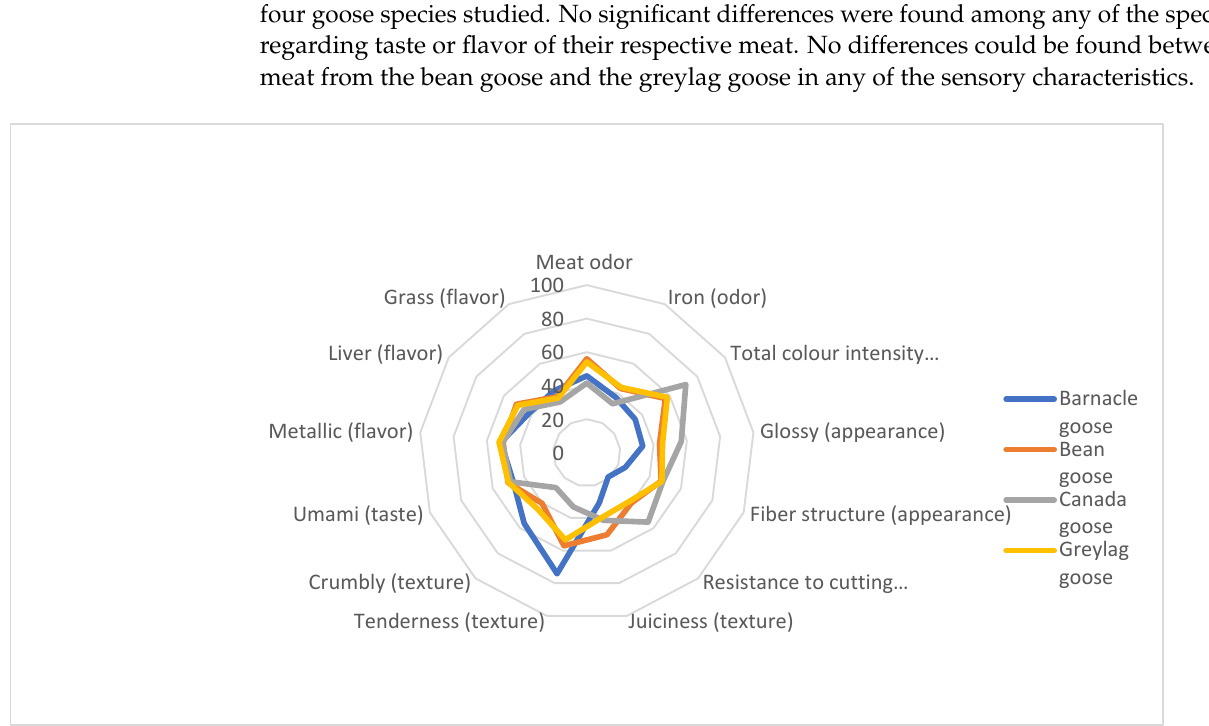
Figure 1. Sensory characteristics of meat from barnacle goose, bean goose, Canada goose and greylag goose.